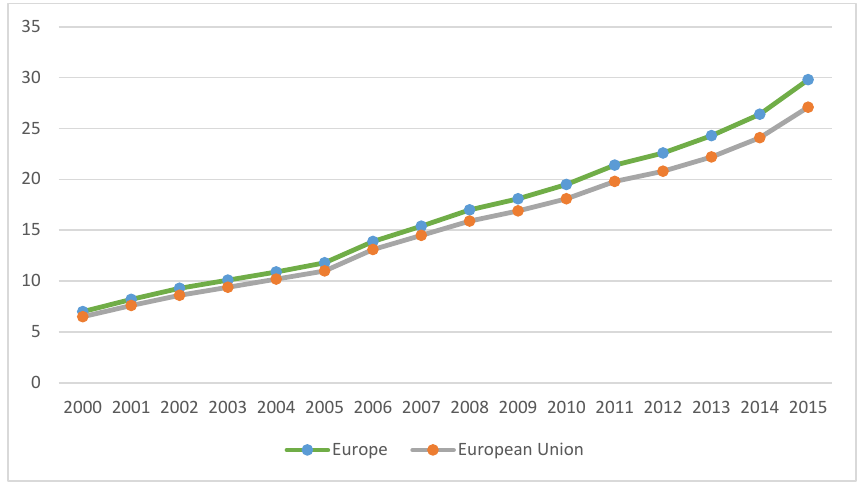
Figure 4. Growth of organic retail sales in Europe and the European Union, 2000–2015 (Billion euros). Source: FiBL-AMI Surveys 2006–2017 and Organic Data Network Surveys